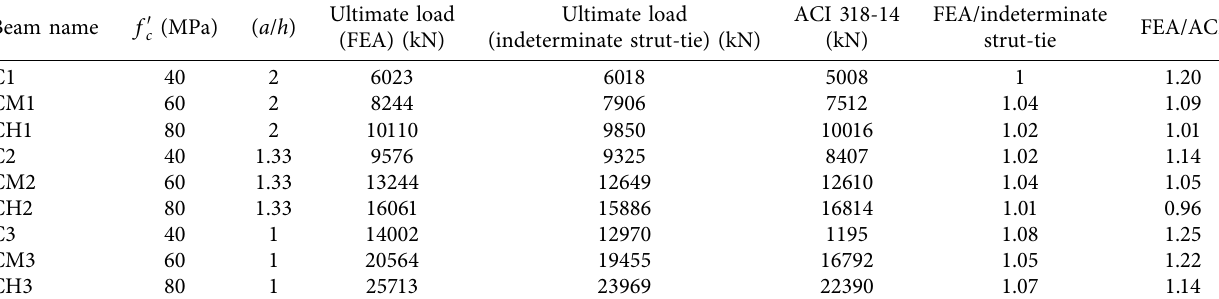
Table 8: A comparison between the numerical modeling and indeterminate strut-tie model. Beam